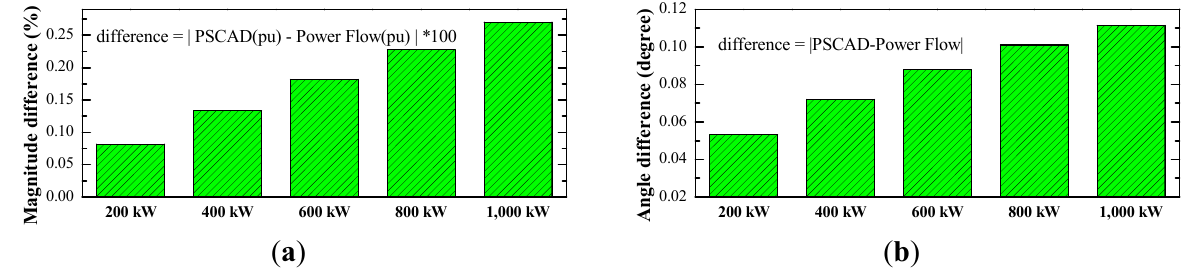
Figure 8. Maximum difference between the power flow results with the simplified DG model and the PSCAD simulation results: ( a ) voltage magnitude and ( b ) voltage angle.